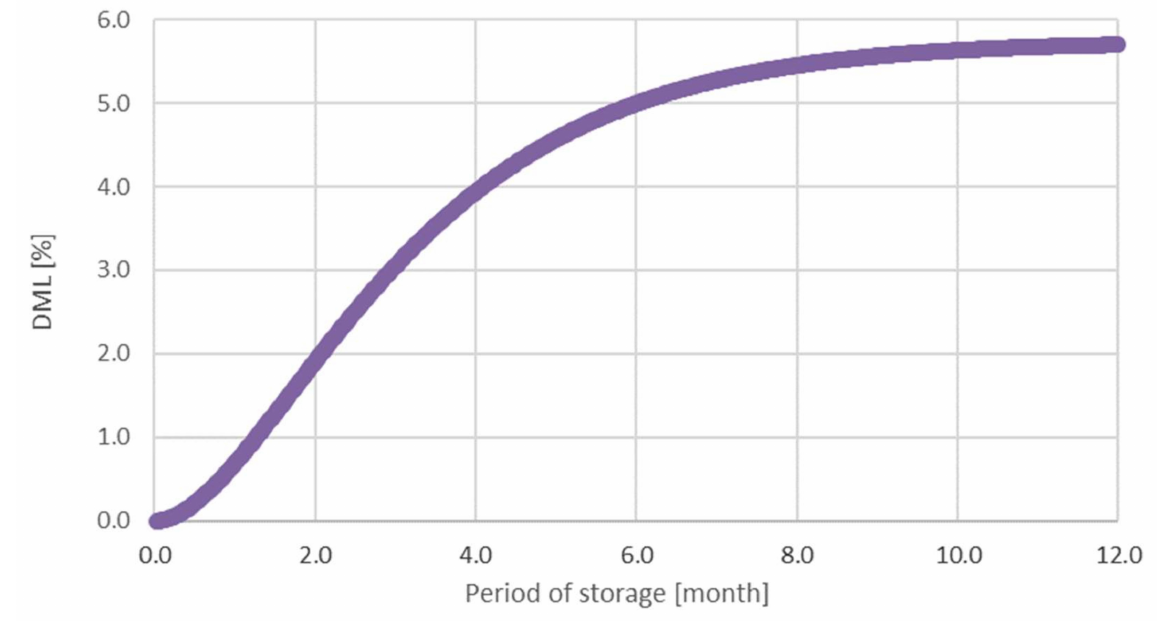
Figure 7. Dependence of DML on the time of the spruce wood